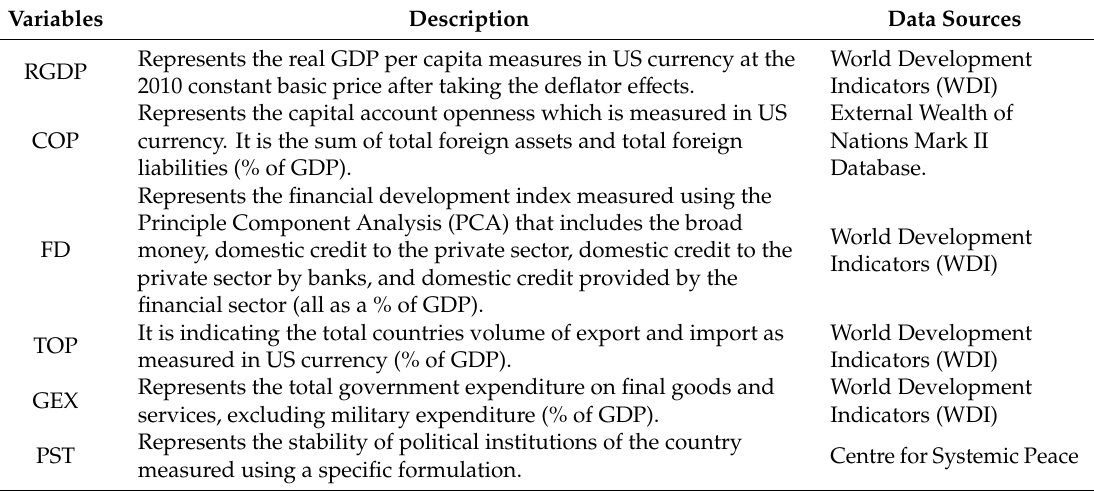
Table 2. Data sources and variable